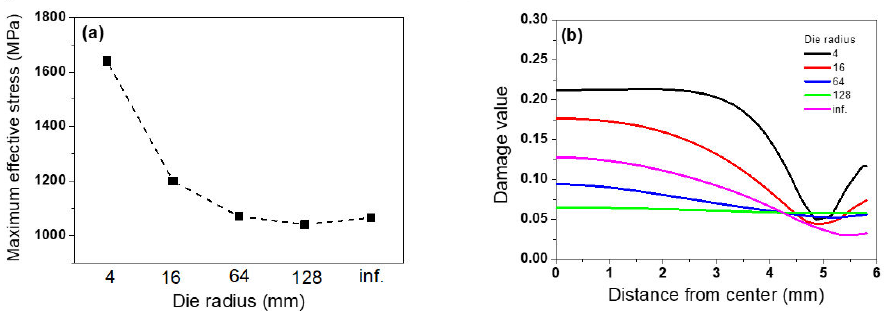
Figure 9. Comparison of ( a ) the maximum effective stress and ( b ) damage value along the radial direction of the wire with the die